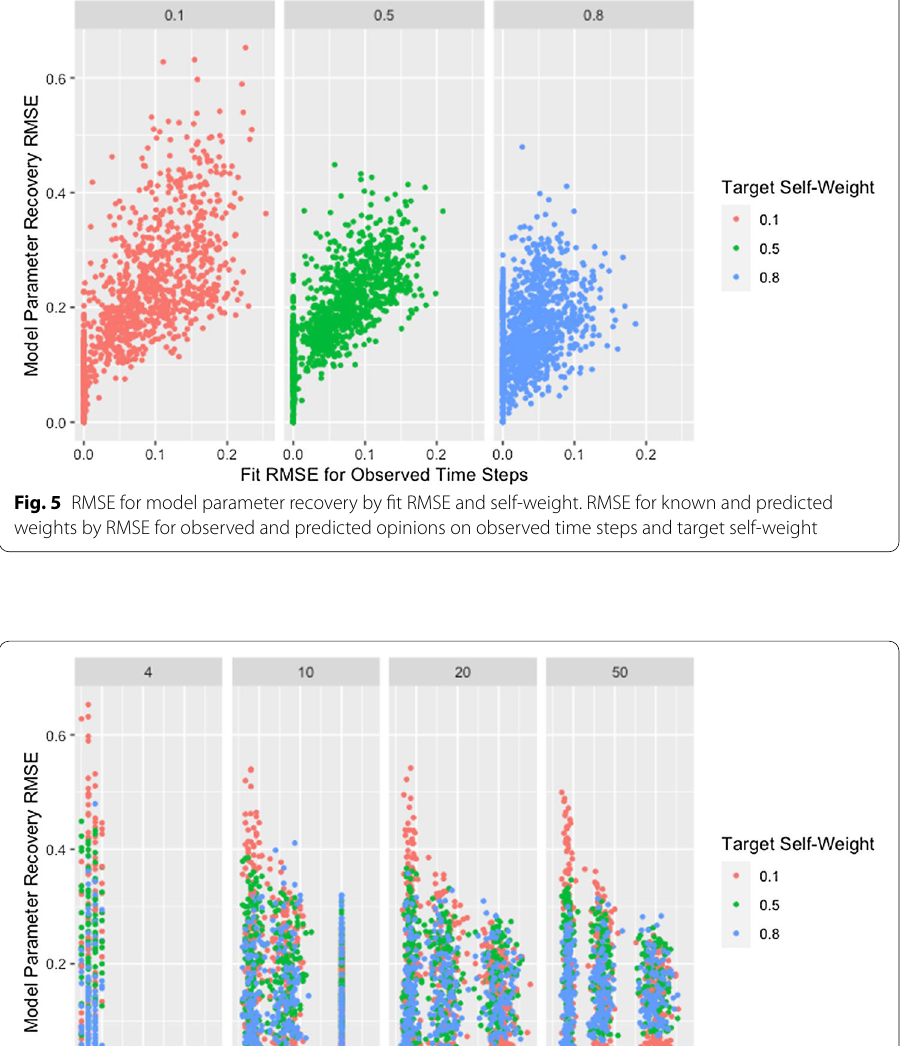
less influenced by the incorrect weights. This allows size to mitigate the effect of low self-weight as we suggested it did for low degree.